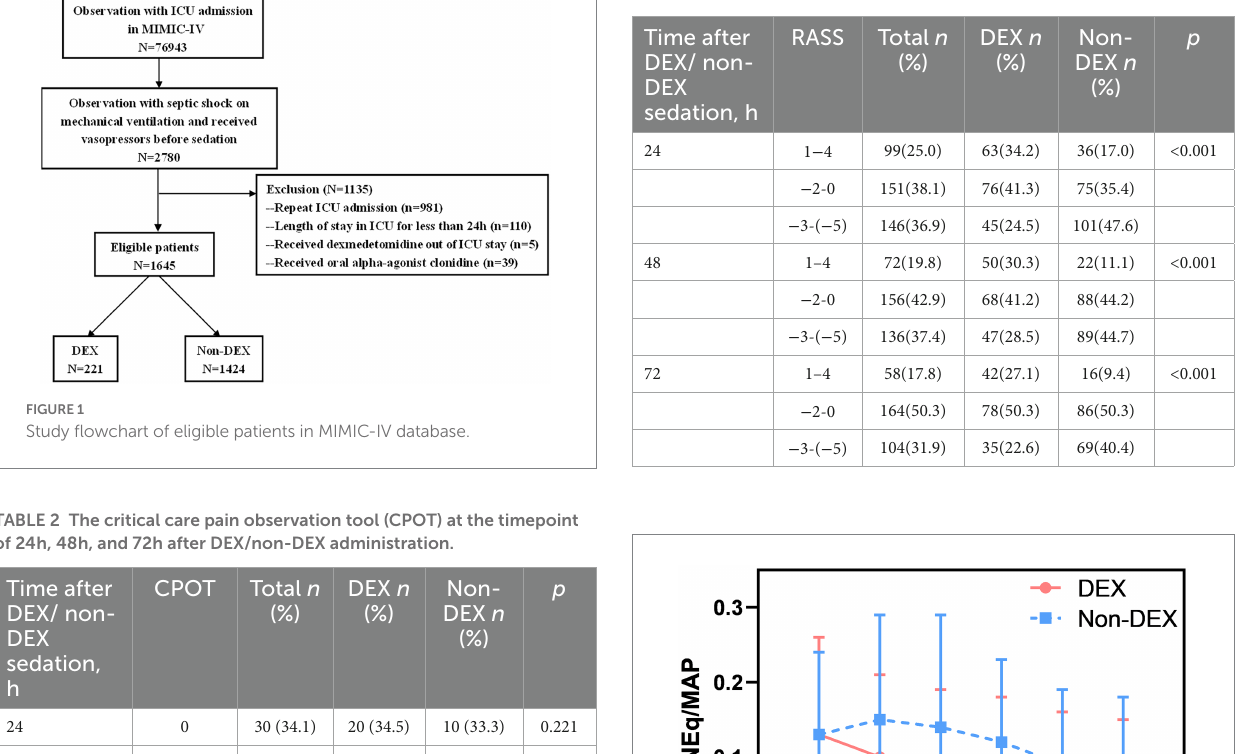
TABLE 3 The Richmond agitation sedation scale (RASS) at the timepoint of 24 h, 48 h, and 72 h after DEX/non-DEX administration.